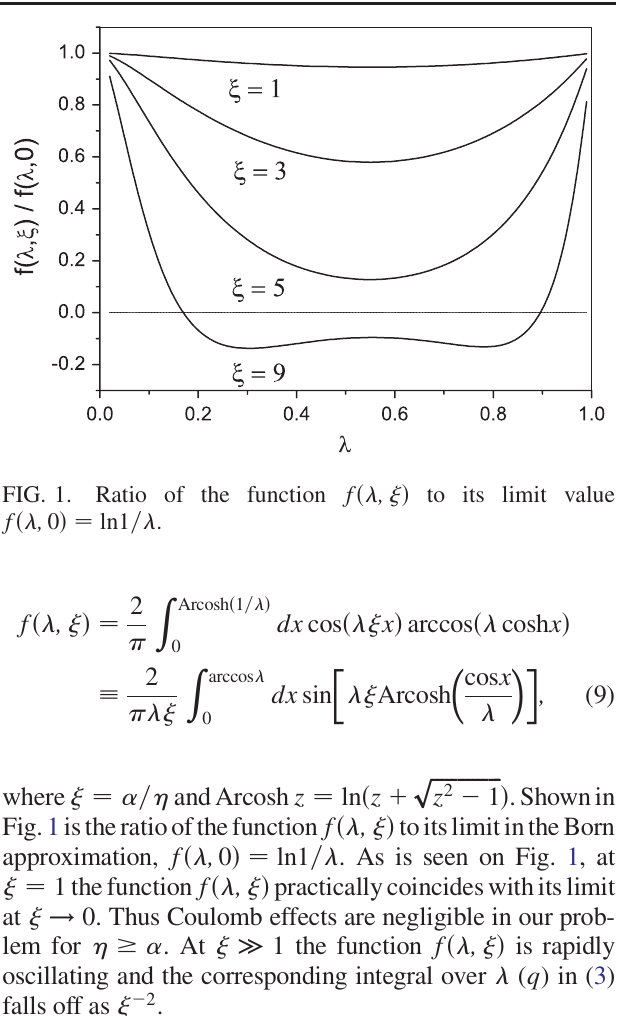
where (cid:10) ¼ (cid:3)=(cid:2) and Arcosh z ¼ ln ð z þ Fig. 1 isthe ratioof the function f ð (cid:9); (cid:10) Þ toits limitinthe Born approximation, f ð (cid:9); 0 Þ ¼ ln1 =(cid:9) . As is seen on Fig. 1, at (cid:10) ¼ 1 the function f ð (cid:9); (cid:10) Þ practically coincides with its limit at (cid:10) ! 0 . Thus Coulomb effects are negligible in our prob- lem for (cid:2) (cid:5) (cid:3) . At (cid:10) (cid:4) 1 the function f ð (cid:9); (cid:10) Þ is rapidly oscillating and the corresponding integral over (cid:9) ( q ) in (3) falls off as (cid:10) (cid:3) 2 .